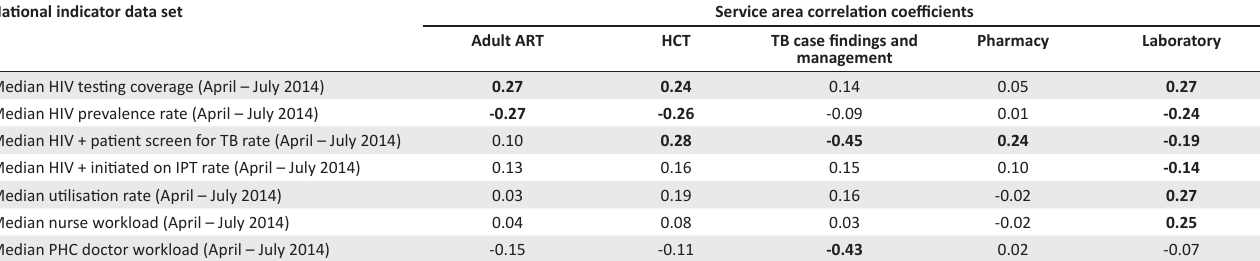
FIGURE 3: Performance of facilities by district health information system indicator pre-and post-continuous quality improvement intervention (April 2014 and October 2015). TABLE 6: Correlations between service area scores and routinely collected national indicator data set. National indicator data set